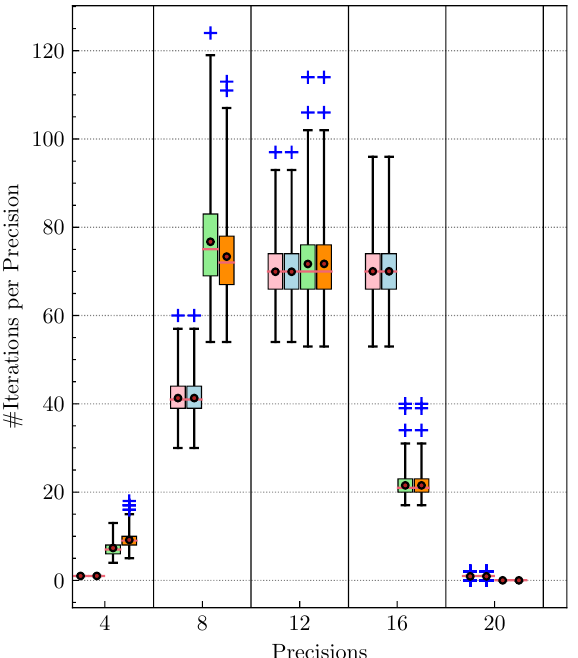
Figure 15. Iterations’ distribution per precision for TOL = 10 − 4